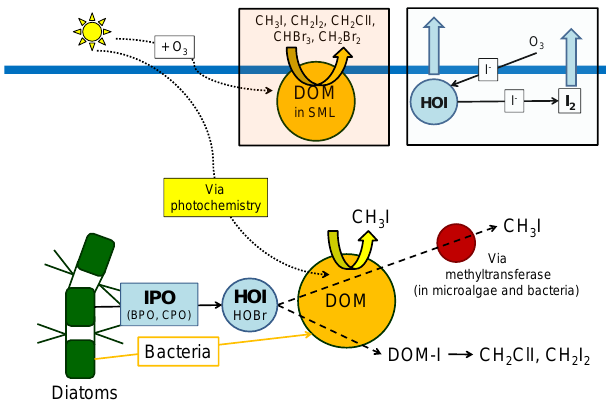
Figure 5. Proposed mechanisms for formation of iodocarbons – re- lease of HOI with the help of iodoperoxiases (IPO), followed by re- action with DOM (dissolved organic matter (DOM) via iodine bind- ing to DOM (DOM-I) to form CH 2 ClI and CH 2 I 2 . CH 3 I forms via photochemistry and/or biological formation via methyltransferases. The box indicates potential formation of halocarbons from DOM in the sea surface microlayer (SML) in addition to inorganic iodine sources there, shown by the light-blue box. For more information on the inorganic iodine chemistry in the SML, please refer to Carpenter et al.